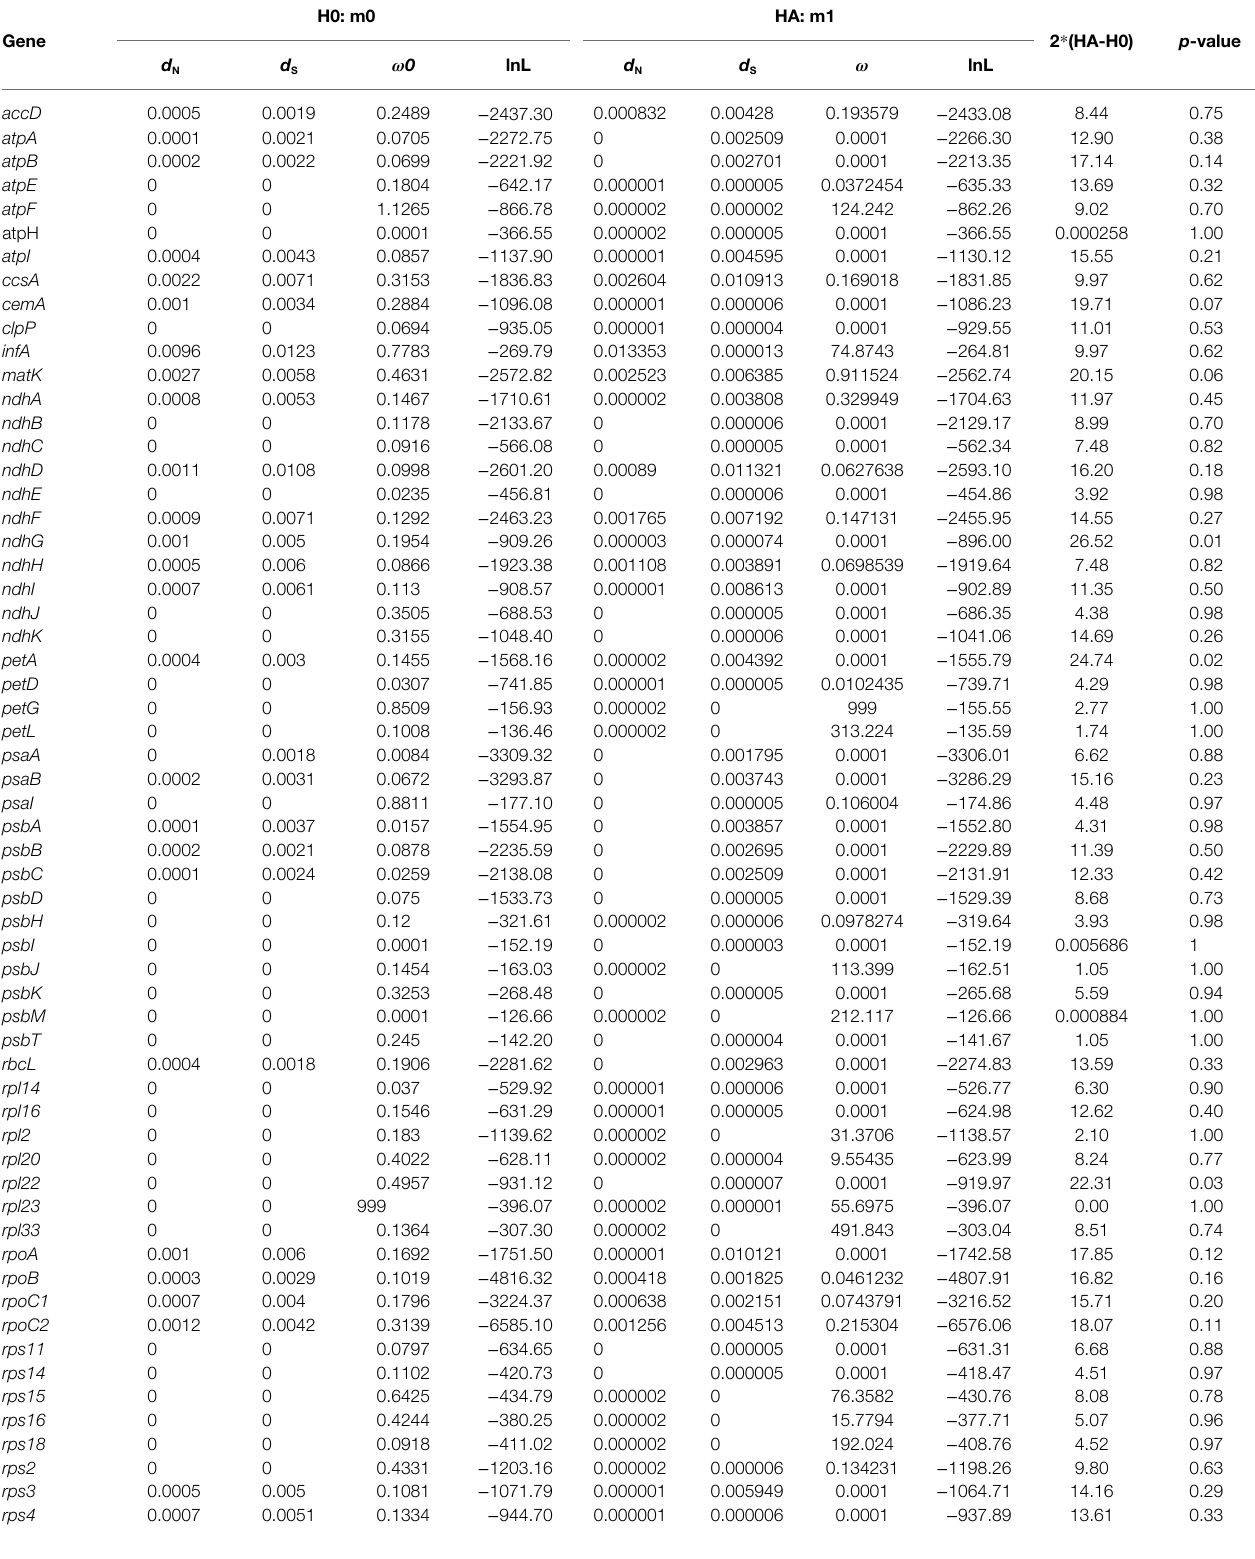
TABLE 2 | Summary of models H0 and HA analyzed in the study. d N , d S , and ω are presented as medians.